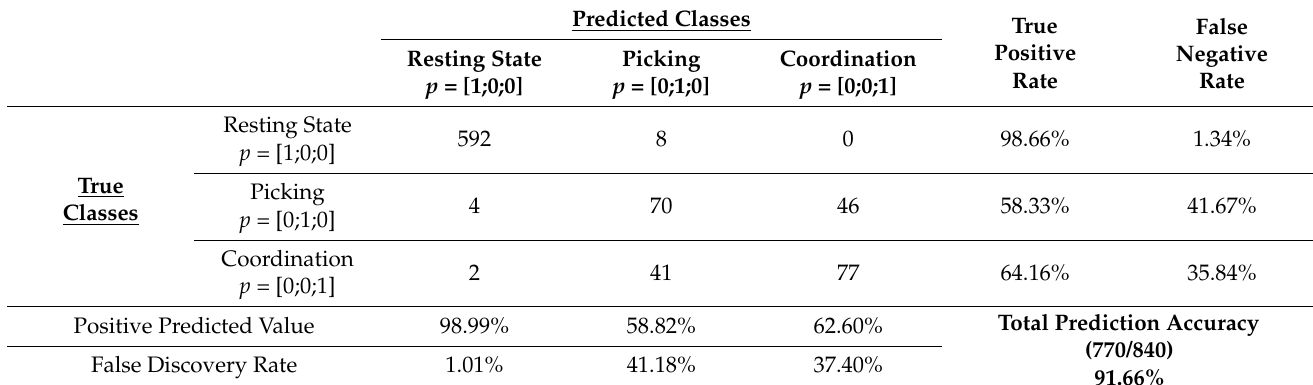
Table 1. Multiclass classification results—random forest using bag of node